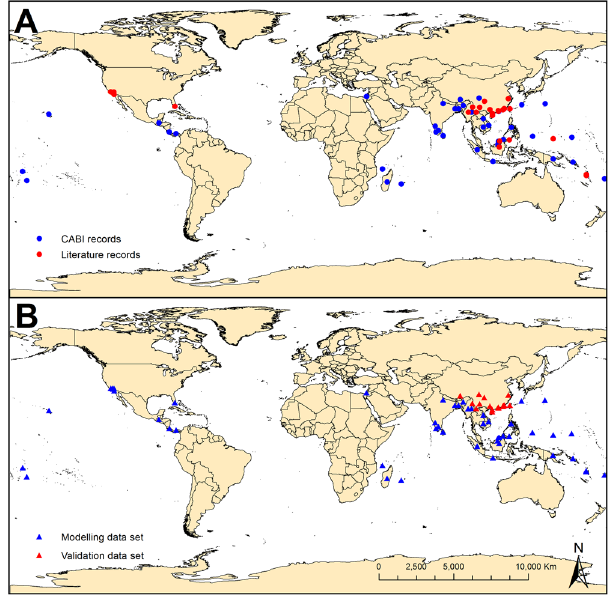
Figure 12. Global known distribution of Euwallacea fornicates . ( A ) Showed the data sources. The red dots were the locations recorded in references, the blue dots were the locations recorded in CABI. ( B ) Showed the usefulness of data. The red triangle showed the locations of validation data set, the blue triangle showed the locations of modeling data set. The map in this figure was generated by GIS software (ArcGIS for Desktop, Software Version 10.2,